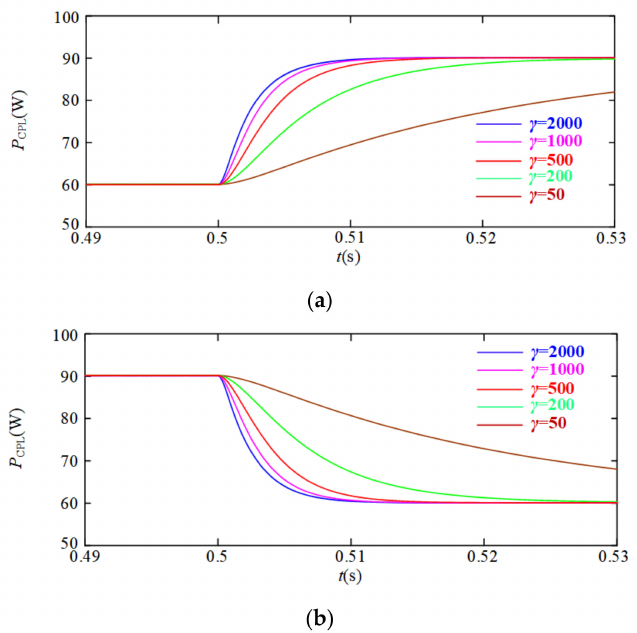
Figure 7. Simulated CPL observation of the different γ when CPL steps up and down. ( a ) CPL: 60 W to 90 W; ( b ) CPL: 90 W to 60